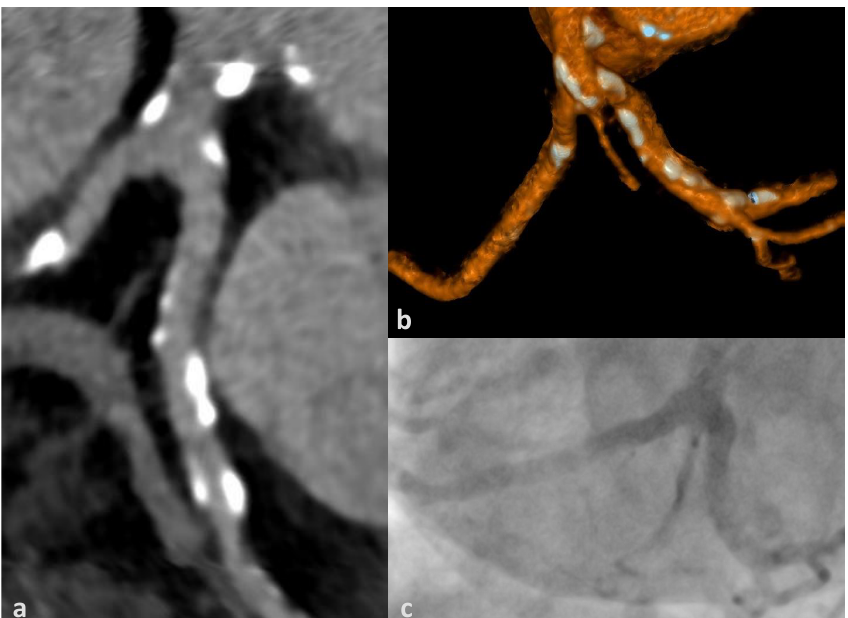
Figure 5. True negative cCTA example (CAC = 1834): Heavily calcified trifurcation of the left main (LM) into left anterior descending (LAD), left circumflex (LCX) and intermediate artery without luminal obstruction depicted as curved multiplanar reformation ( a ), volume rendered technique ( b ) and corresponding projection of invasive coronary angiography ( c ). CAC = coronary artery calcium